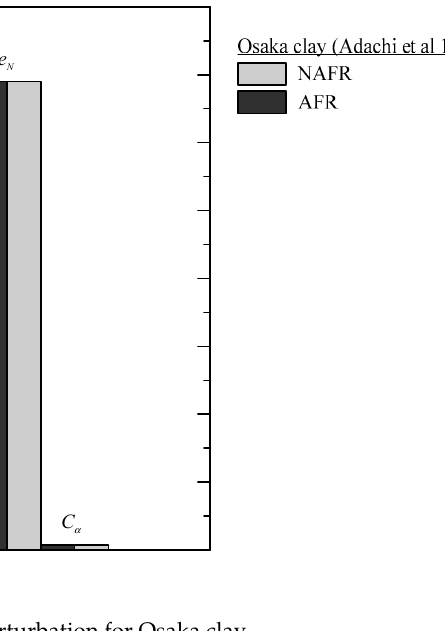
Figure 8. Comparison of the measured and the predicted consolidated drained triaxial compression